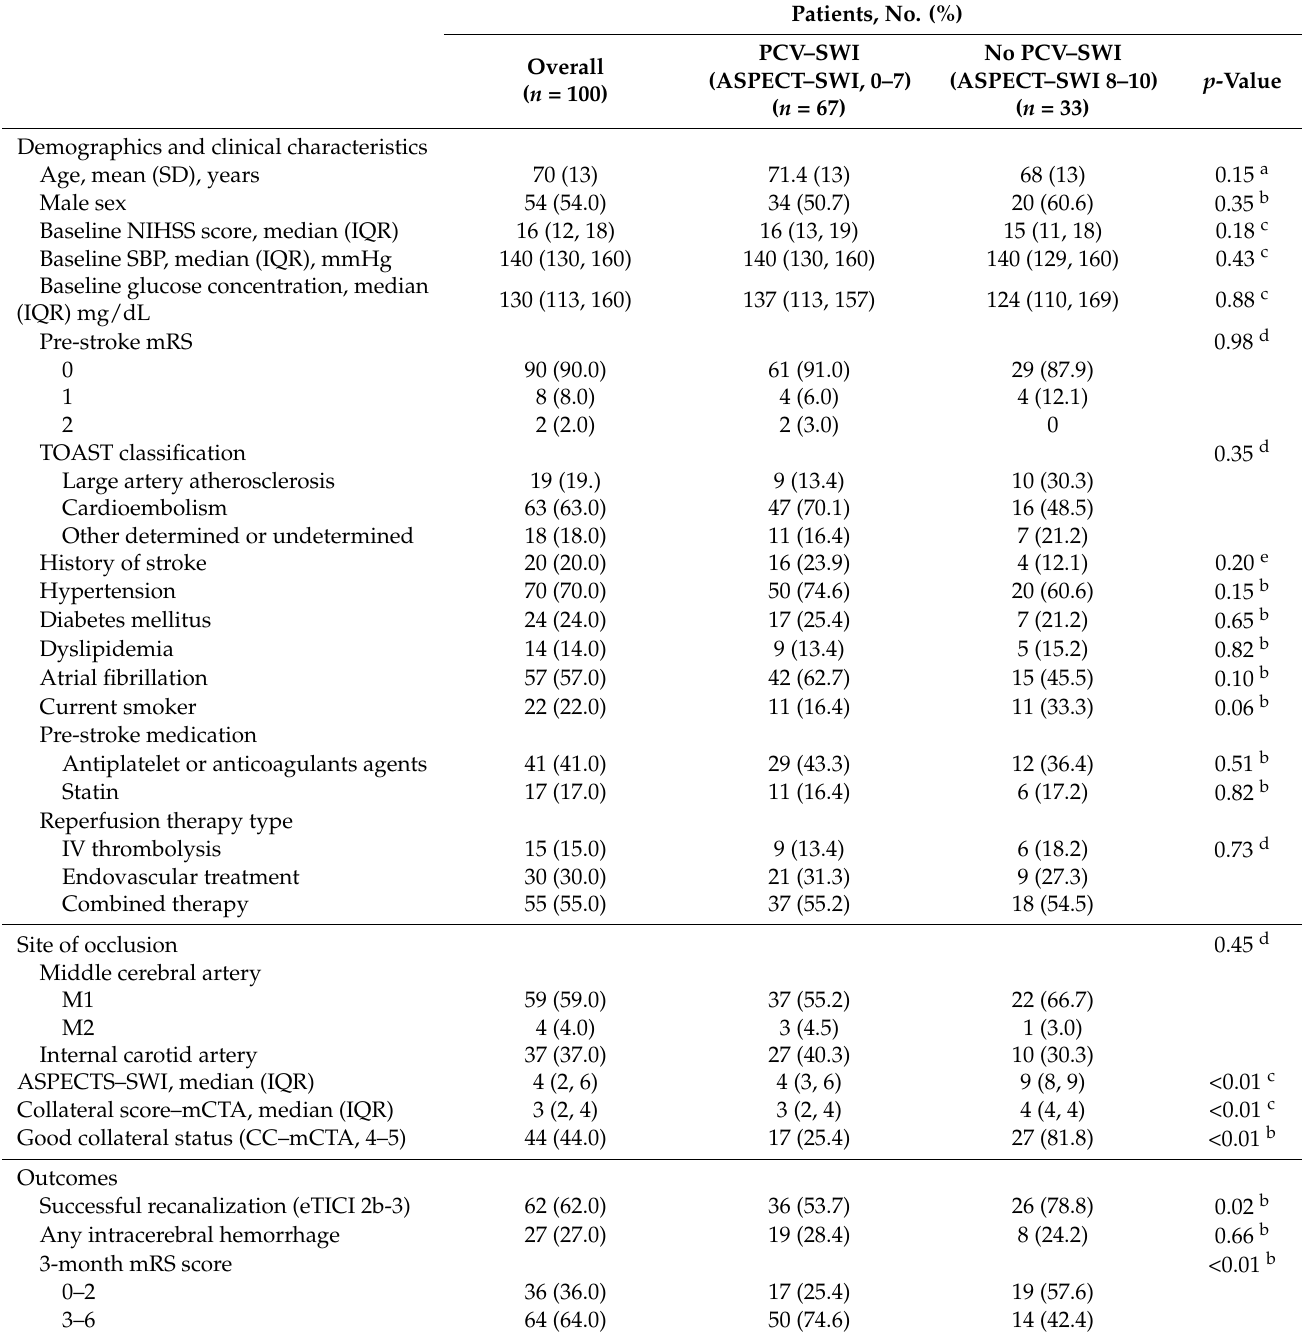
Table 1. Patient characteristics, treatments, and outcomes according to the prominent cortical vessels on